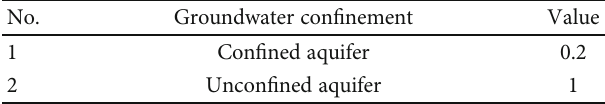
Table 4: Groundwater con fi nement value/rating in the study area. Table 5: Overlying strata value/rating in the study area.